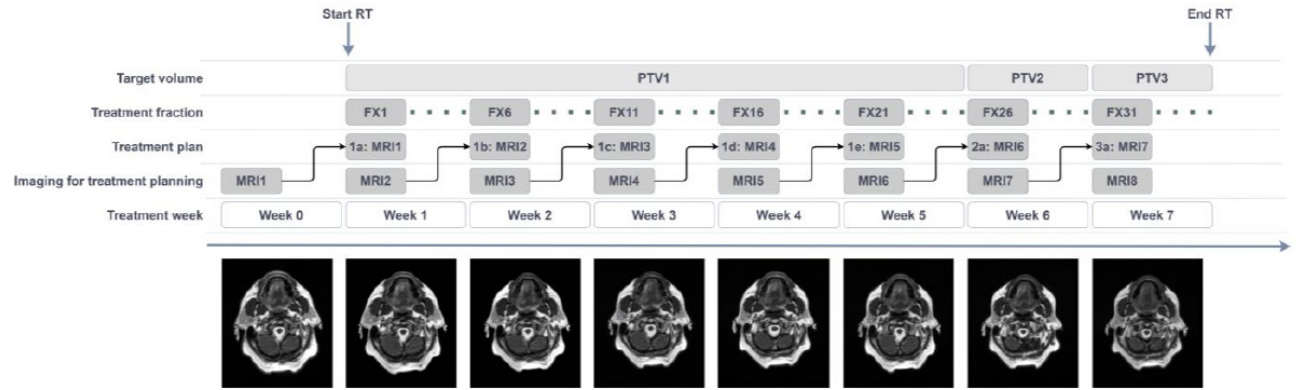
Figure 1. Treatment schedule for weekly MRI-guided offline adaptive radiotherapy in the MARTHA trial. The numbering of the treatment plans (1a–3a) and the number of the MRIs (MRI1–MRI8) is used throughout the manuscript. RT = radiotherapy, PTV = planning target volume, MRI = magnetic resonance imaging, FX = fraction.